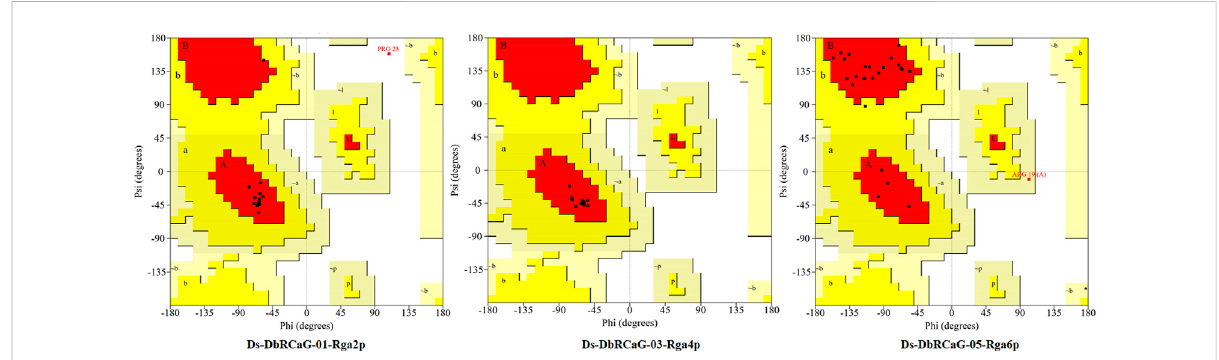
FIGURE 2 Ramachandran plot of Ds-DbRCaG-01-Rga2p, Ds-DbRCaG-03-Rga4p, and Ds-DbRCaG-05-Rga6p. Their most favored region is red, additionally allowed in yellow, generously allowed in light yellow, and disallowed regions are indicated in white fi elds.